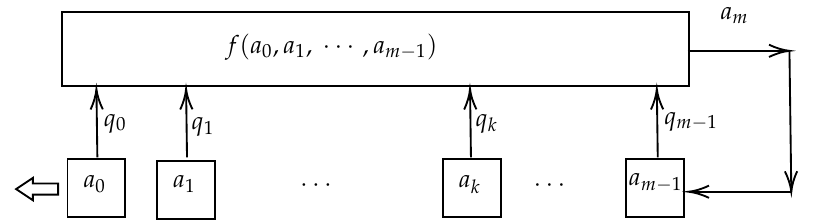
Figure 1. A Linear Feedback Shift Register of length m